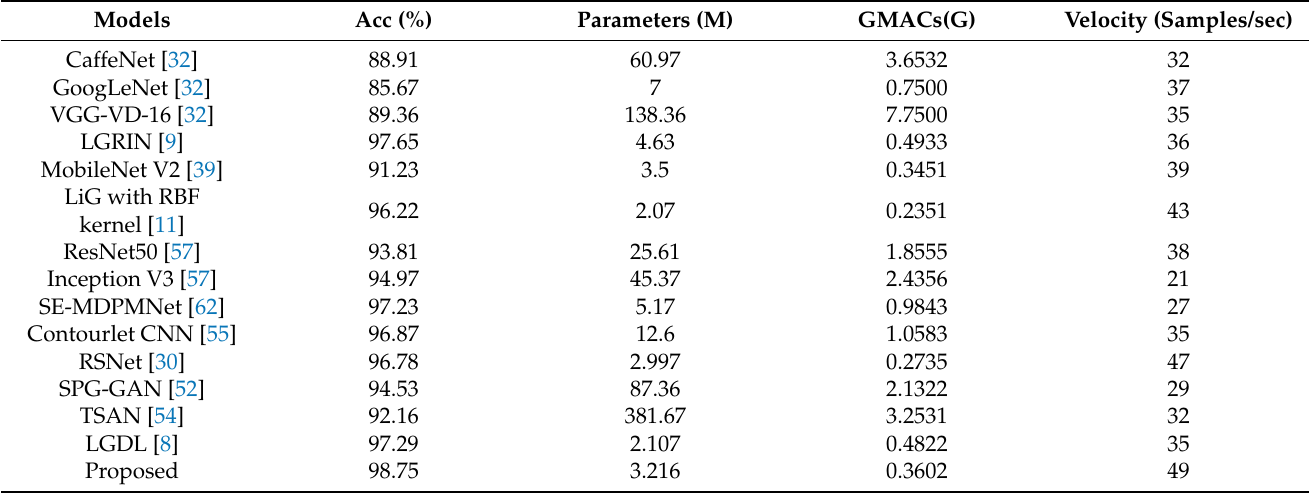
Table 5. Evaluation of size of